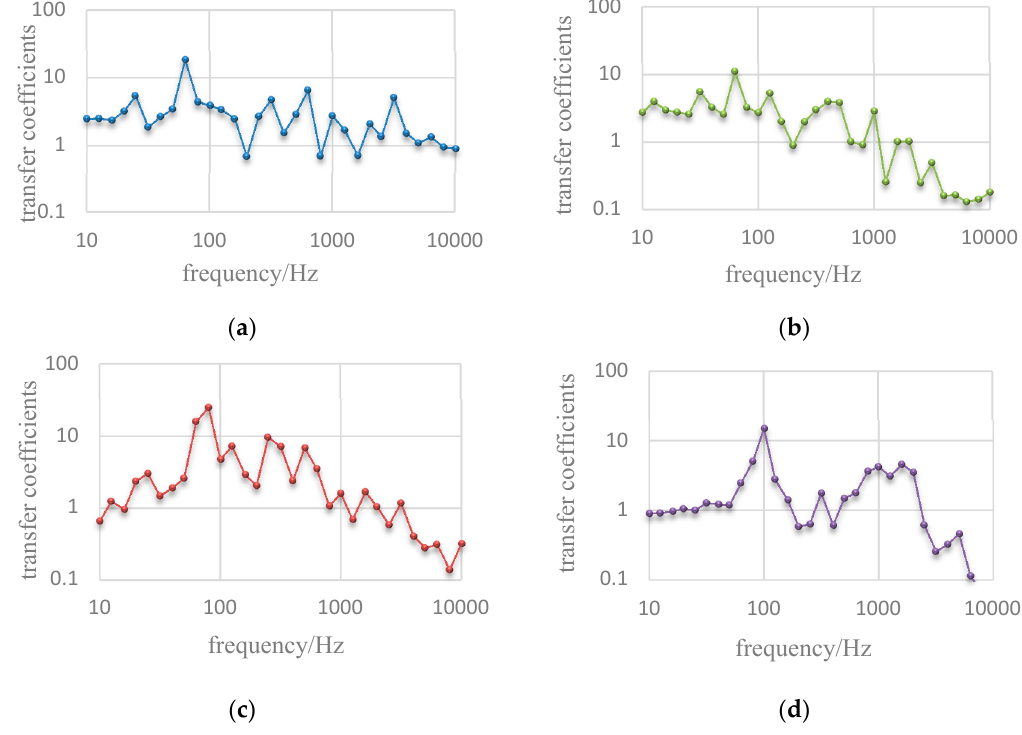
Figure 10. Test results under 2000 r/min: ( a ) SLMB; ( b ) DLMB; ( c ) BCR and ( d ) RP.